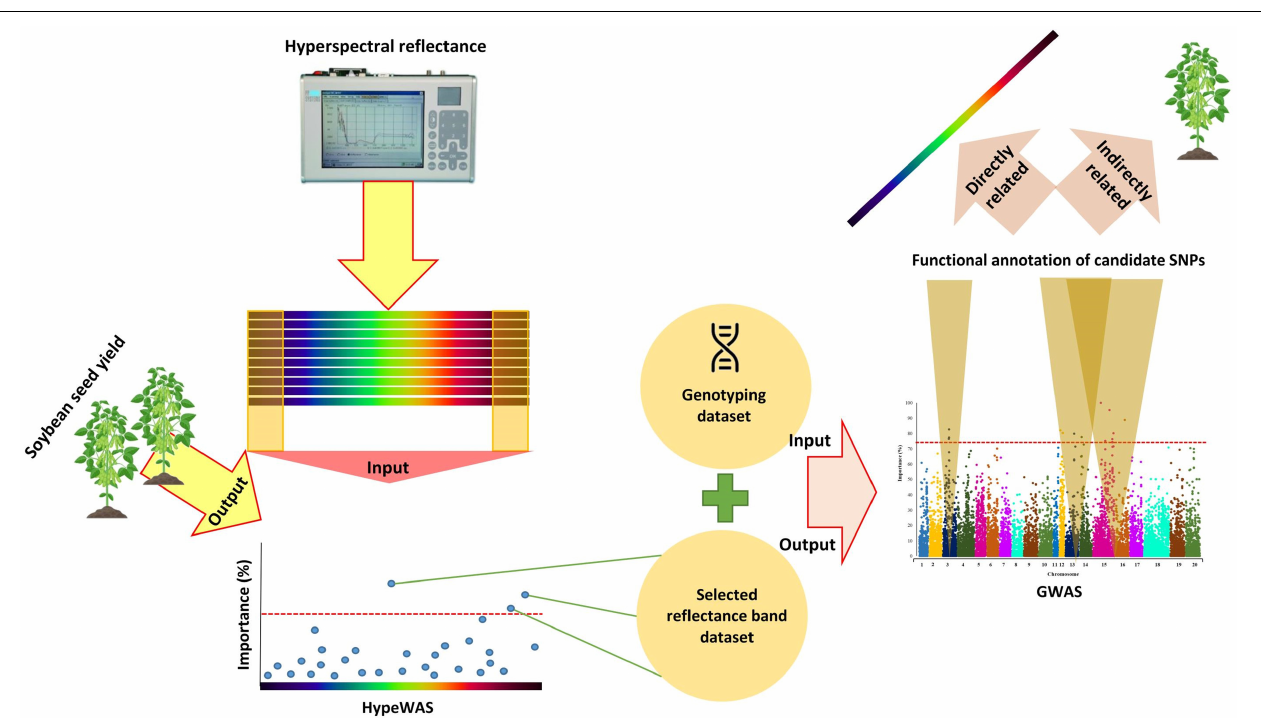
FIGURE 2 | The schematic workflow of the hierarchical data integration strategy of HypWAS and GWAS in Soybean.